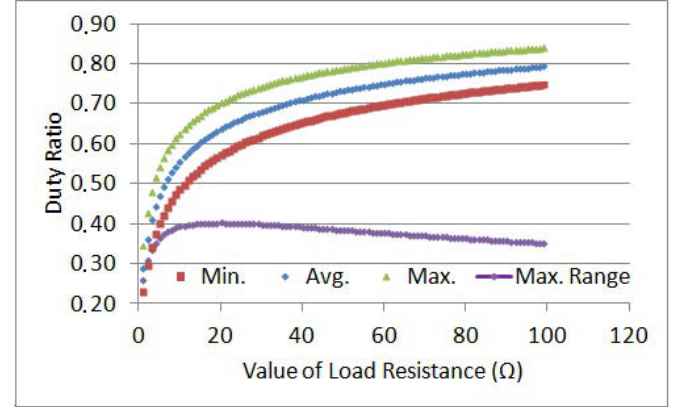
Figure 6. Variation of duty ratio (minimum, averaged, and maximum) and load resistance.